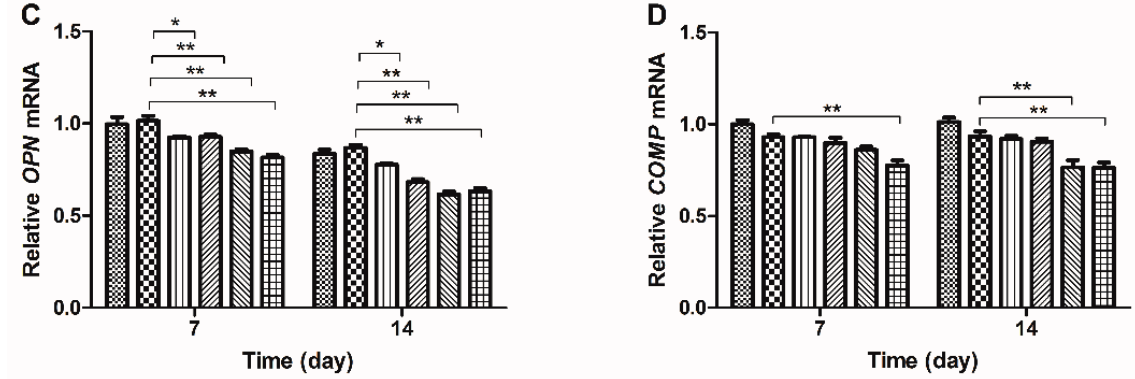
Figure 6. Expressions of differentiation related gene markers of MSCs treated with different gradients of BMP3/TGF- β on days 7 and 14. Expression of novel NP markers ( A ) KRT19 , and characteristic markers of osteocytes ( B ) ALP ; ( C ) OPN and ( D ) COMP were normalized to 18S and to the day 7 control group. C = control; T = 10 ng/mL TGF- β ; 1 BT = 1 ng/mL BMP3/10 ng/mL TGF- β ; 10 BT = 10 ng/mL BMP3/10 ng/mL TGF- β ; 50 BT = 50 ng/mL BMP3/10 ng/mL TGF- β , 100 BT = 100 ng/mL BMP3/10 ng/mL TGF- β . Data represent mean ± SD; * p < 0.05, ** p < 0.01.